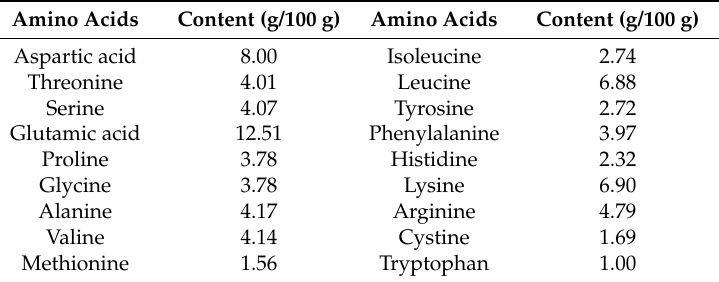
Table 2. Amino acids content in sheep placental